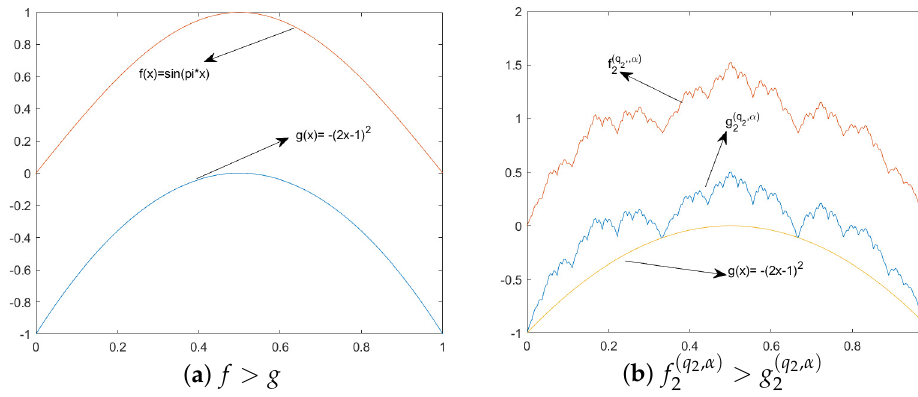
Figure 4. MKZ fractal functions preserving